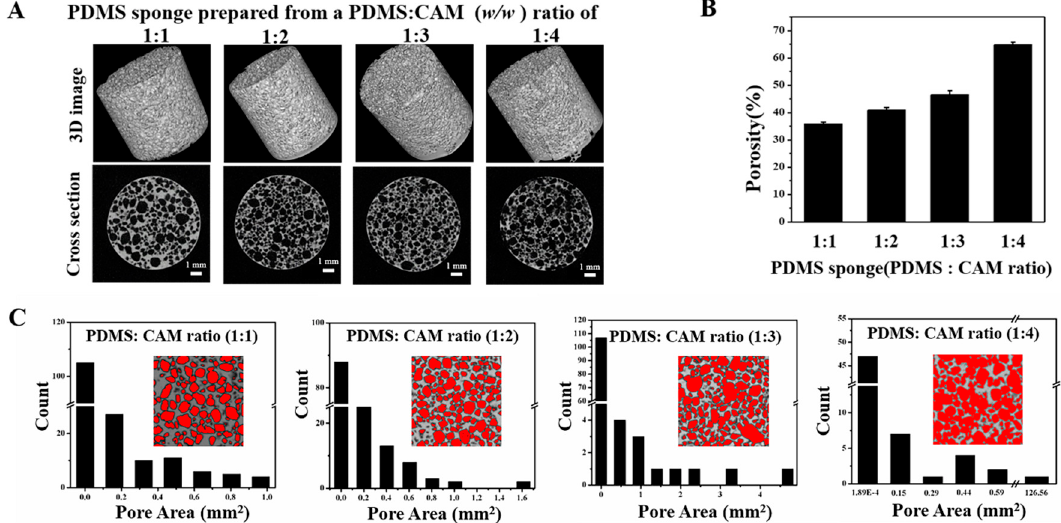
Figure 3. Micro-CT characterization of porous PDMS sponge. ( A ) Reconstructed 3D image of PDMS sponges and section view of PDMS sponges; ( B ) Pore percentages quantified by NIH Image J particle analysis; and ( C ) Pore distribution of PDMS sponges analyzed by NIH Image J particle analysis.